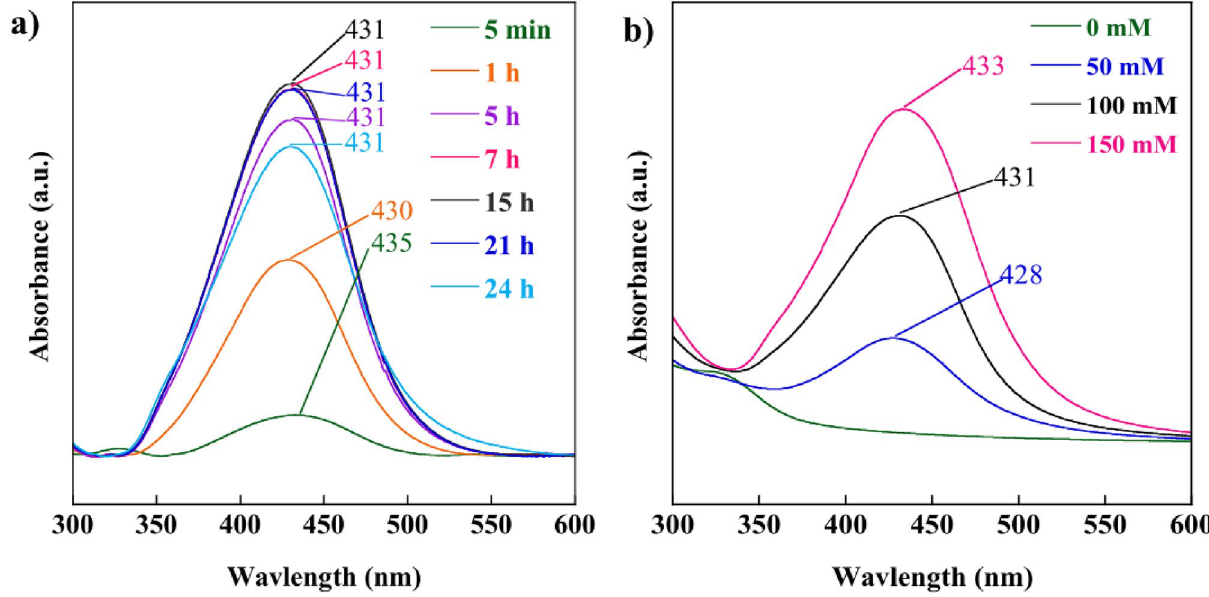
Figure 1. UV–Vis spectra of AgNPs at ( a ) different reaction times and ( b ) different